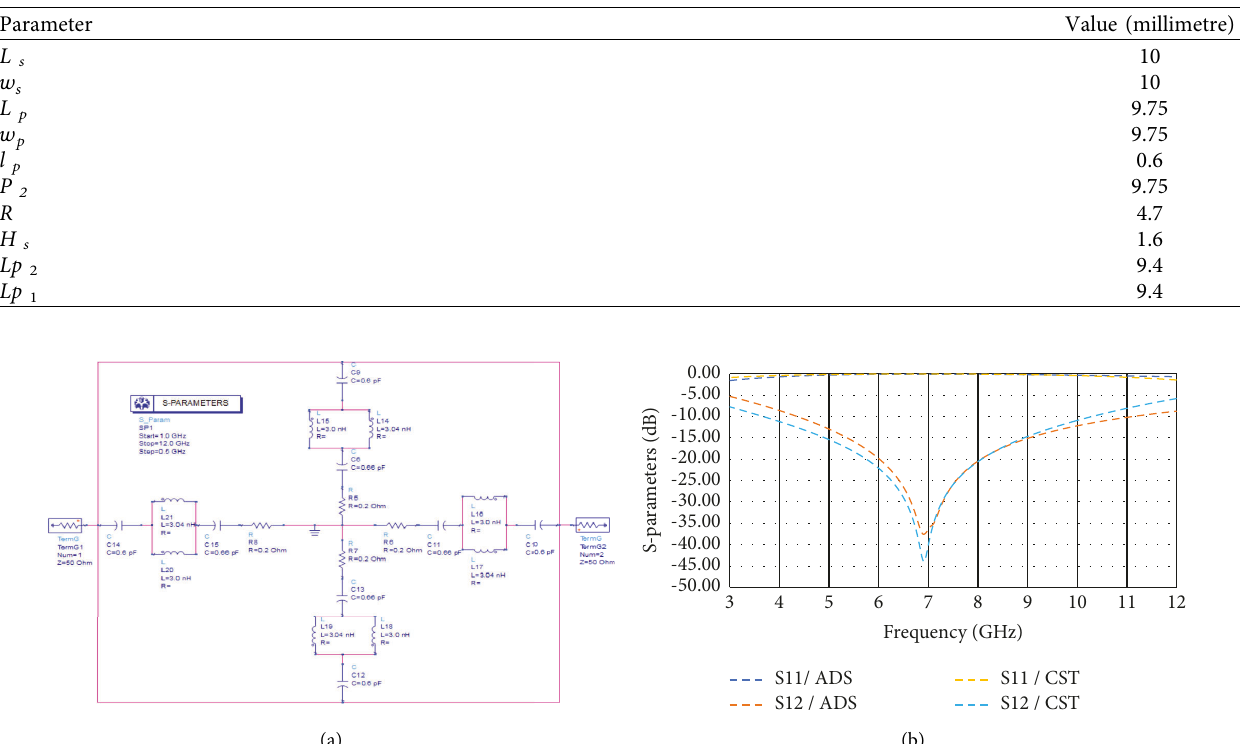
Figure 4: (a) Unit cell steps. (b) Unit cell excitation. (c) S parameters. Table 2: Design parameters of reported unit cell.